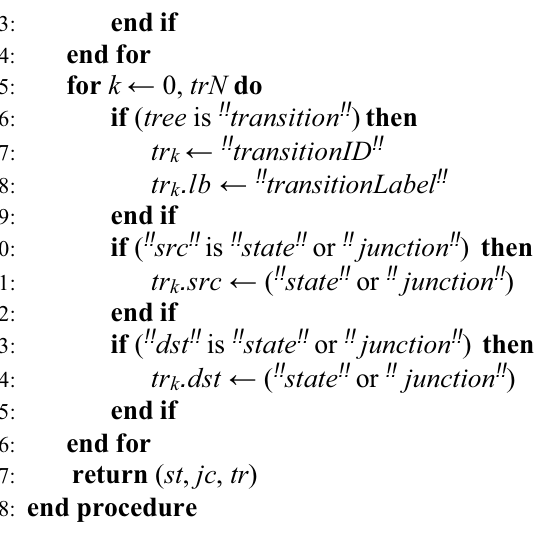
Fig.3 performs the translation from XML to a finite state machine intermediate specification for a deterministic or nondeterministic model. Line 3